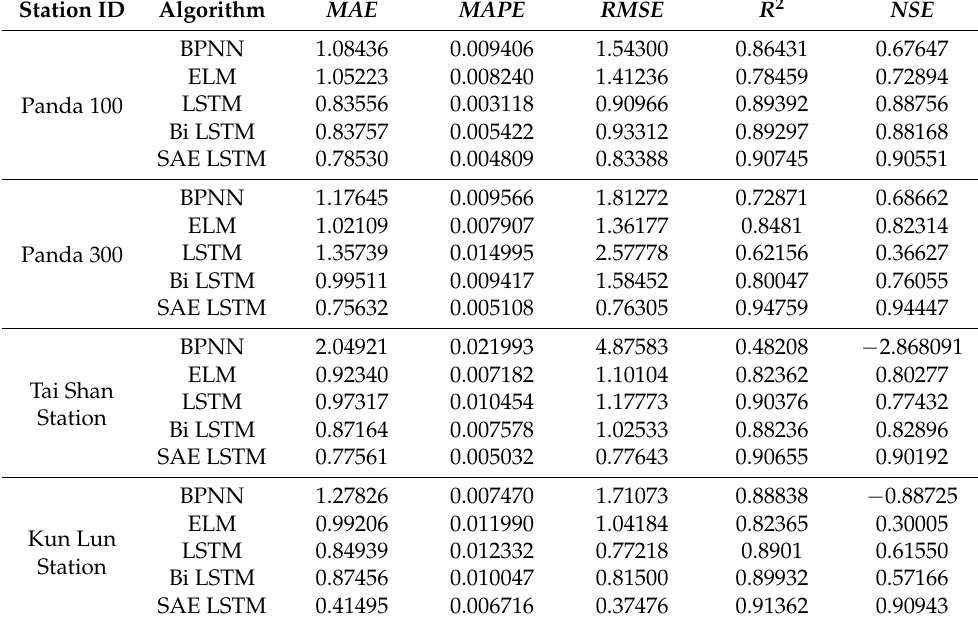
Table 7. Eight-hour wind speed performance results from station Panda 100 to Kun Lun